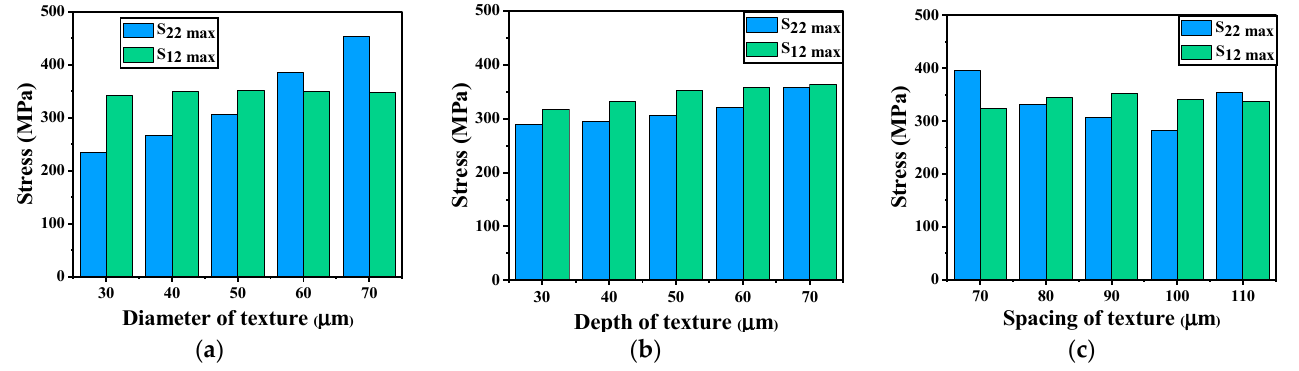
Figure 10. Effects of diameter, depth, and spacing of columnar texture on two stresses: ( a ) variable: diameter, depth: 50 μ m, spacing: 90 μ m, ( b ) variable: depth, diameter: 50 μ m, spacing: 90 μ m, ( c ) variable: spacing, diameter: 50 μ m, depth: 50 μ m.